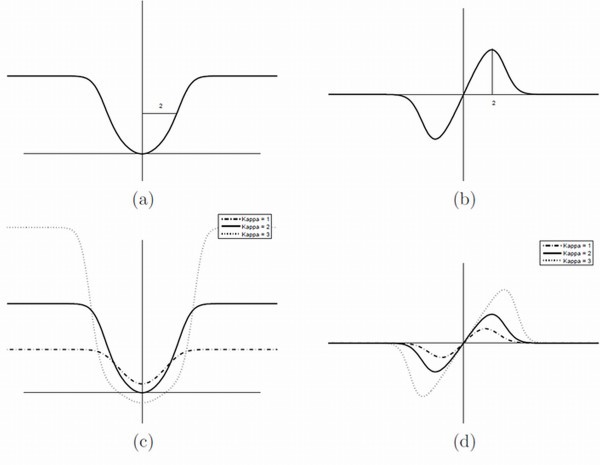
Equivalent M-estimator. Equivalent M-estimator and outlier influence functions for the augmented superimposition with AWGN modelling (a) and (b) with σ = 1 and κ = 2. (c) and (d) similarly but for σ = 1 and κ = 1, 2, 3 or equivalently κ = 2 and σ = 0.5, 1, 1.5 values, suggesting automatic adaptation of the M-estimator in function of the inlier-distribution or typical variation.